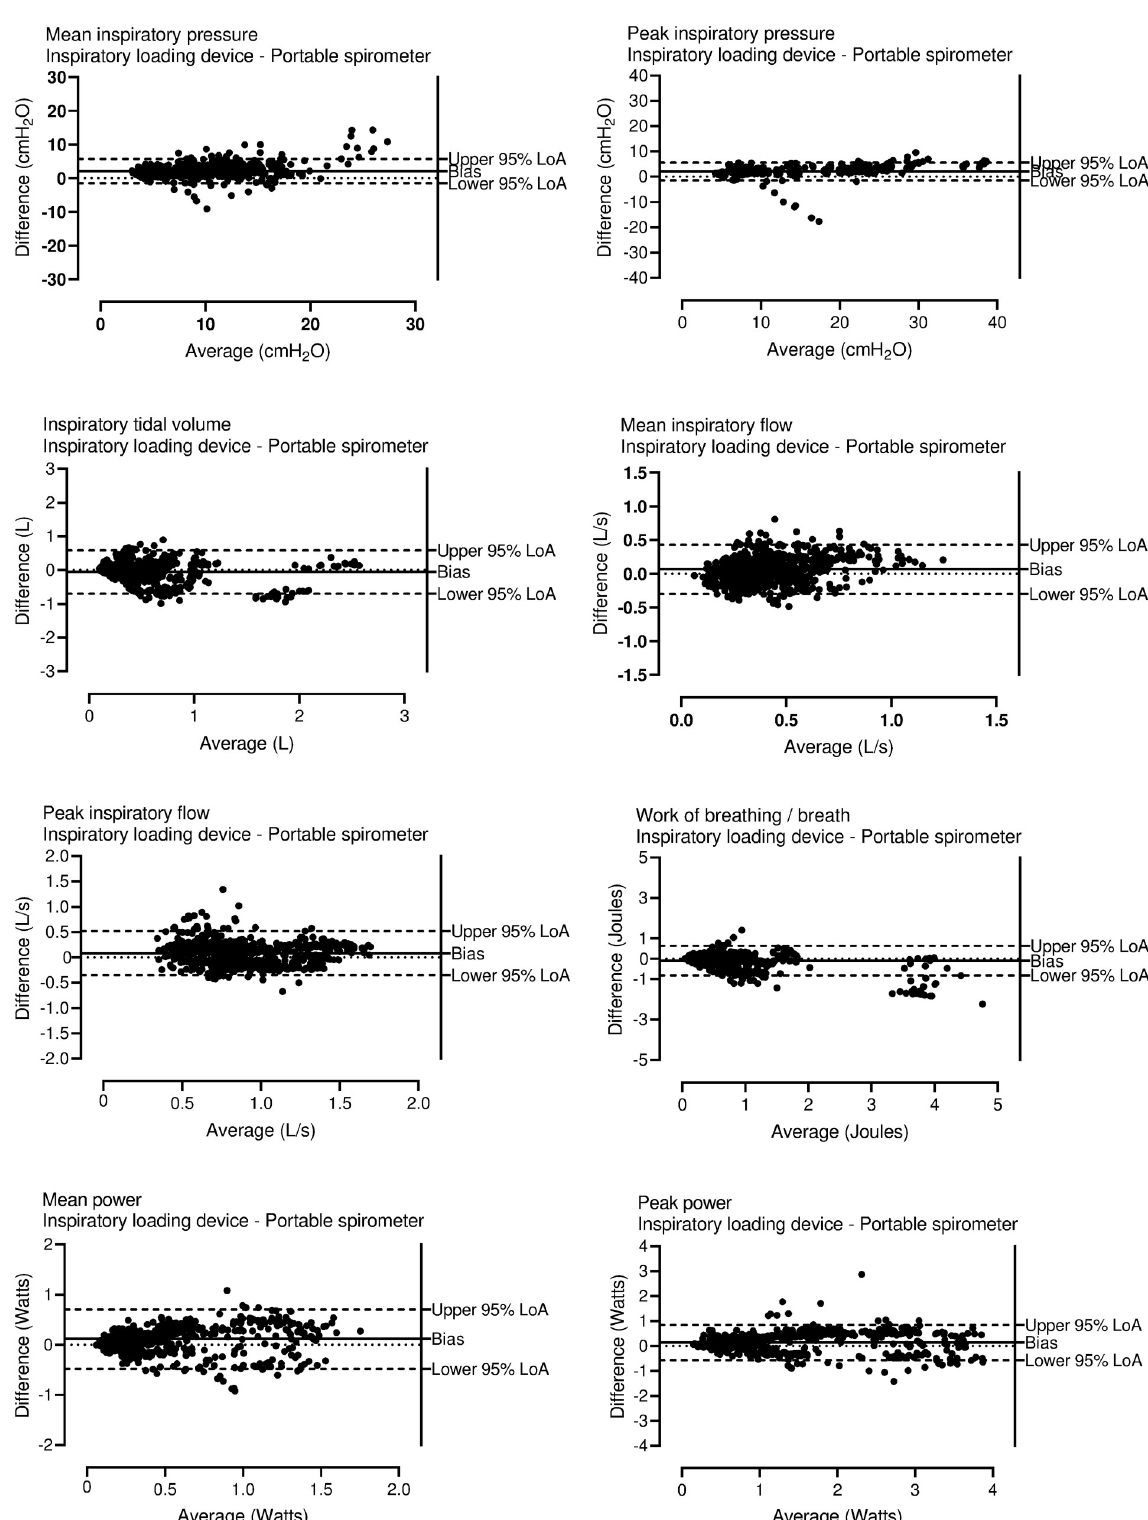
Fig 3. Breathing characteristics: Bland-Altman plots. Agreement between estimates of several breathing characteristics of individual breaths performed during inspiratory muscle training as assessed by the portable spirometer and the electronic inspiratory training device. LoA = Limit of